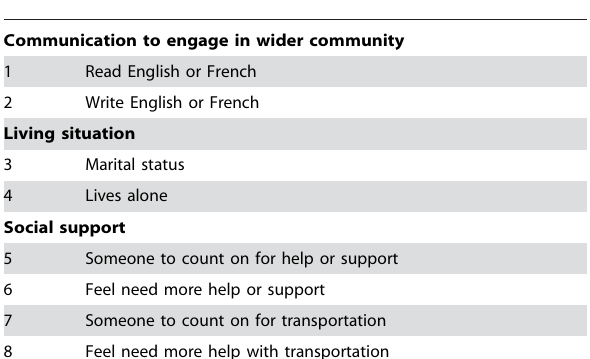
Table 1. Items aggregated in the social vulnerability index used in each survey.